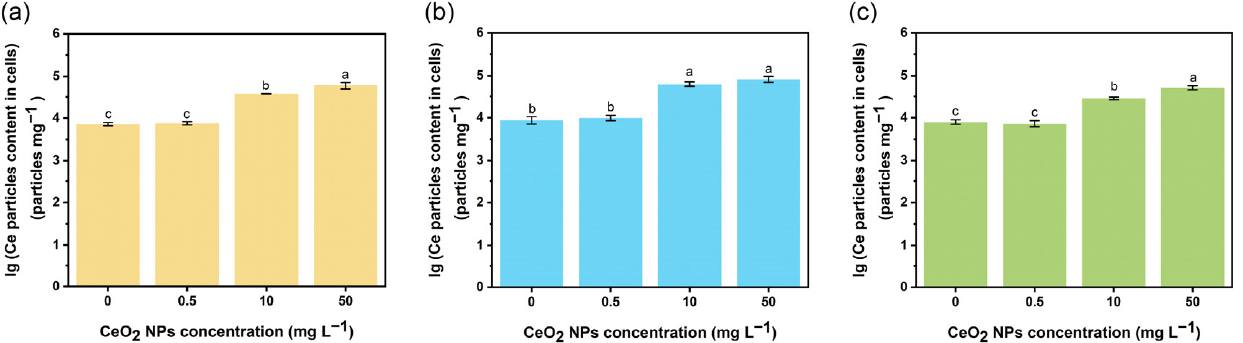
Figure 2. Uptake of CeO 2 NPs by E. coli cells after exposure. Particle content CeO 2 NPs internalized in E. coli cells in System 1 ( a ), System 2 ( b ) and System 3 ( c ). Lowercase letters represent the statistical significance among different concentrations of CeO 2 NPs.